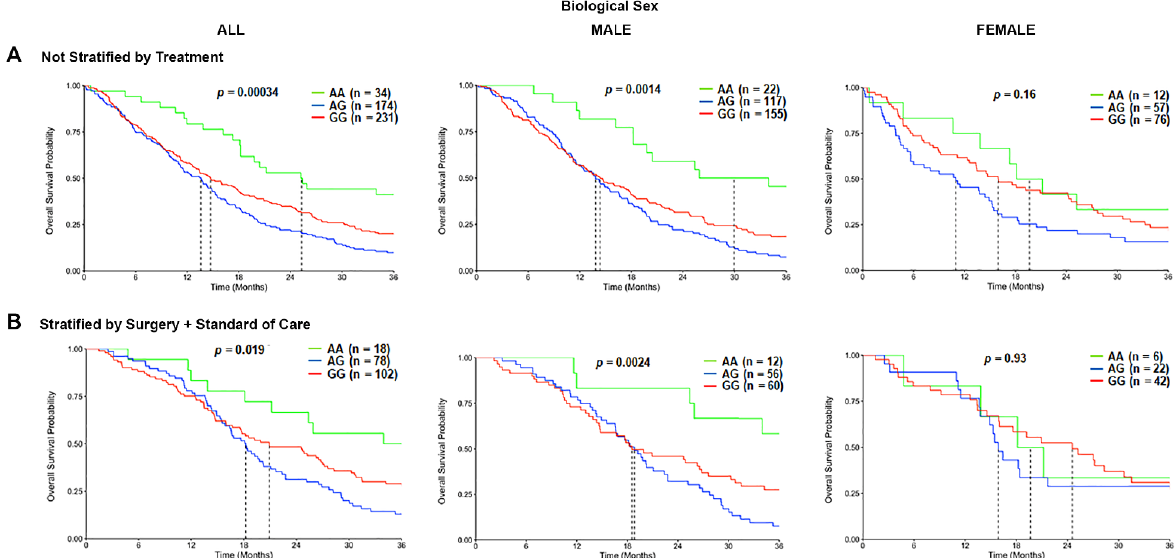
Figure 3. Overall survival (OS) curves in the carriers of the TSPO rs6971 polymorphism stratified by genotype, biological sex, and treatment, using the CCF cohort. ( A ) Overall survival probability curves in the entire population ( left panel ), male subgroup ( middle panel ), and female subgroup ( right panel ) comparing the wild-type A/A, heterozygous A/G, and variant G/G genotypes for the TSPO rs6971 polymorphism using the patient data from the CCF cohort. ( B ) Overall survival curves stratifying by treatment (those who underwent surgical resection followed by standard of care treatment) in the entire population ( left panel ), the male subgroup ( middle panel ), and the female subgroup ( right panel ) comparing the wild-type A/A, heterozygous A/G, and variant G/G genotypes for the TSPO rs6971 polymorphism. Genotype patient numbers and p -values are indicated in each graph, and the median and statistical data are in Table S1.